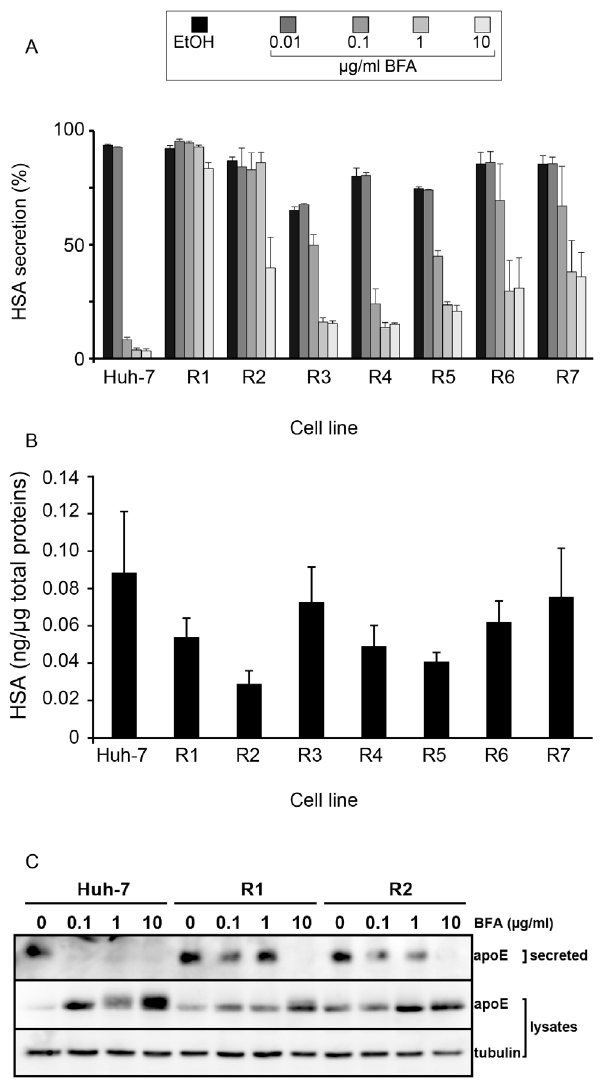
Figure 4. Serum albumin and apolipoprotein E secretion in BFA-resistant cells. (A) Albumin secretion. Cells of the indicated cell lines were seeded in 12-well plates, and cultured in the presence of BFA for 24 h. The amounts of human serum albumin (HSA) in the conditioned culture media and in cell lysates were quantified with an ELISA assay and expressed as percentages of HSA secretion. Error bars represent the SEM of 4 independent experiments performed in duplicates. (B) Basal HSA expression levels. HSA of the indicated cell lines were quantified from cell lysates (in the absence of BFA treatment) by ELISA and normalized to the total protein concentration. (C) Apolipoprotein E (apoE) secretion. Cells were cultured in 24-well plates, in the presence of the indicated concentrations of BFA for 8 h. The amounts of apoE in cell lysates and culture media and of tubulin in cell lysates were analyzed by immunoblotting. Error bars represent the SEM of 3 independent experiments.